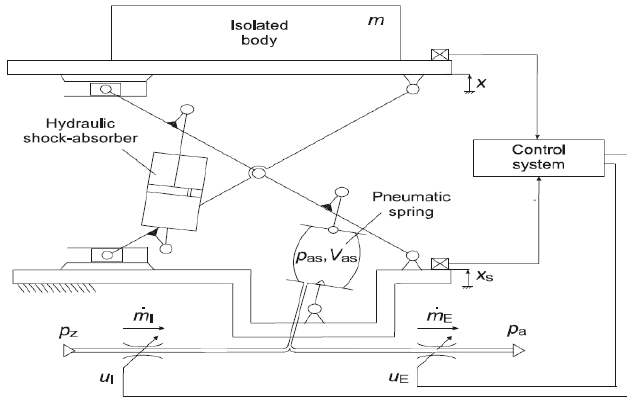
Figure 8. Active seating suspension system structure [69].